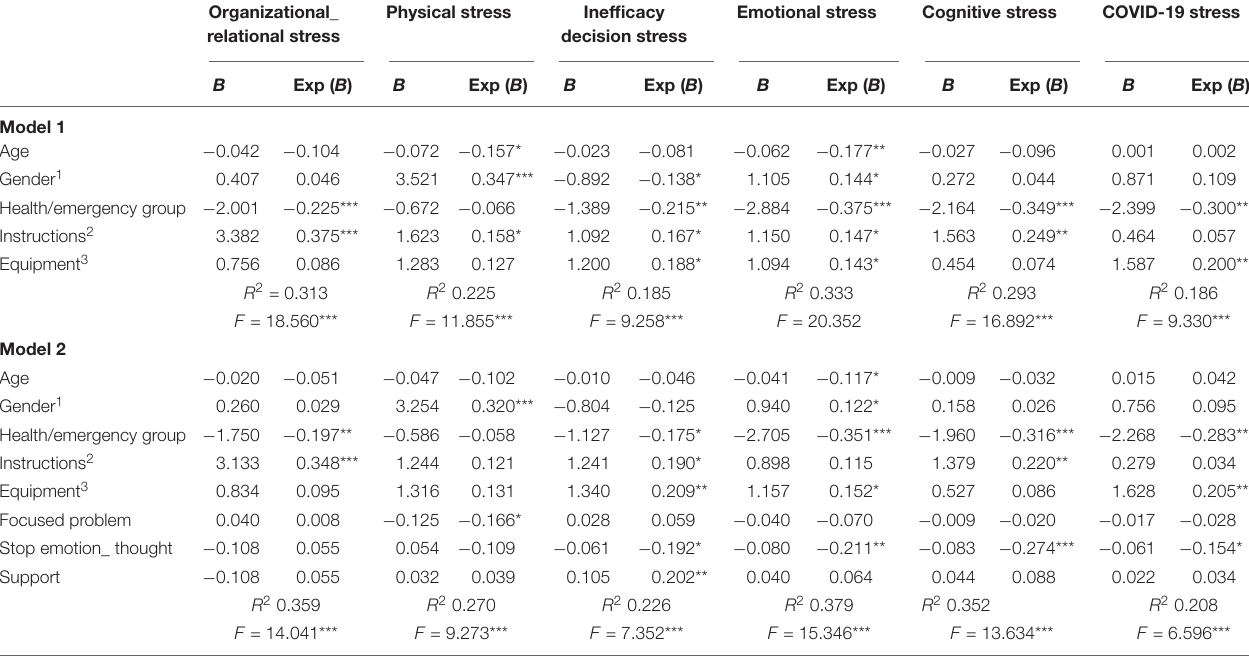
TABLE 3 | Hierarchical regressions on ESQ scales ( n = 210).